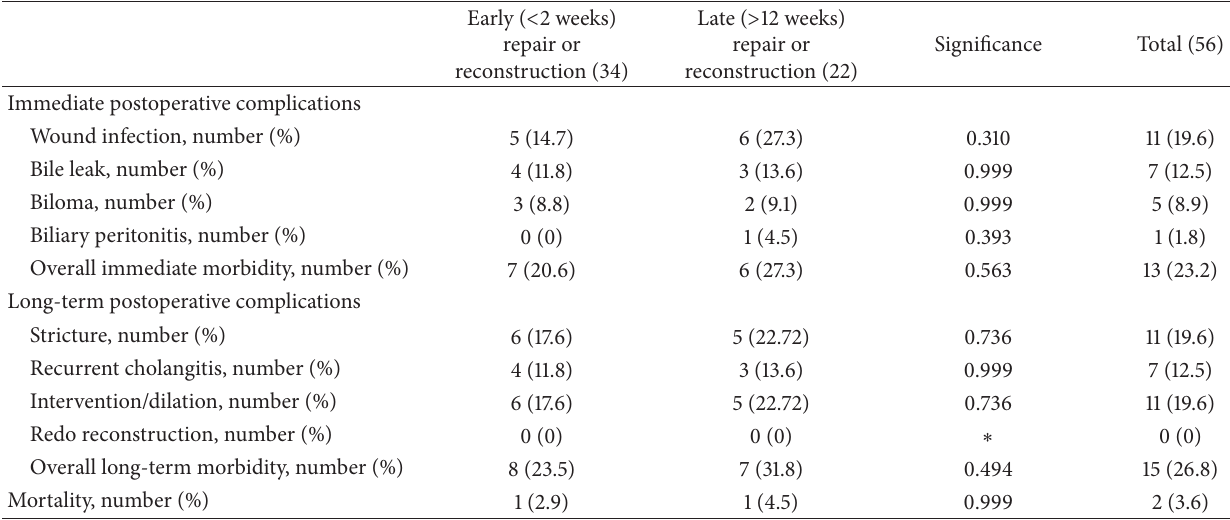
Table 5: Results of biliary reconstruction by